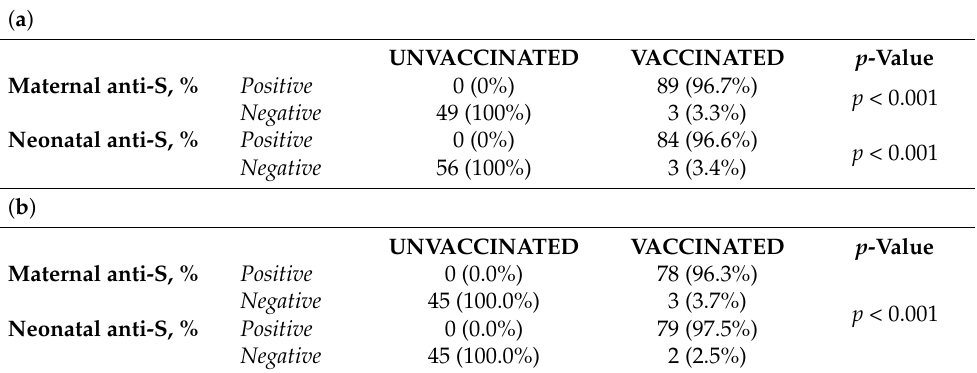
Table 4. Maternal and neonatal anti-s in ( a ) all the vaccinated vs. unvaccinated subjects or in ( b ) mother-neonate